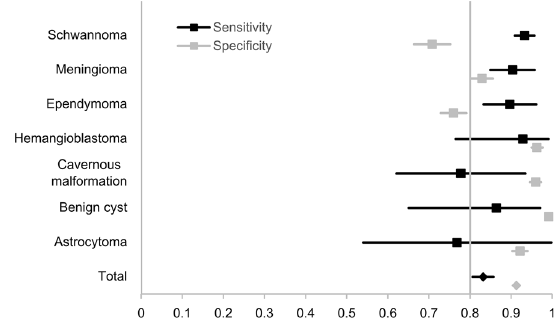
Figure 1. The validity of MRI for pathology.